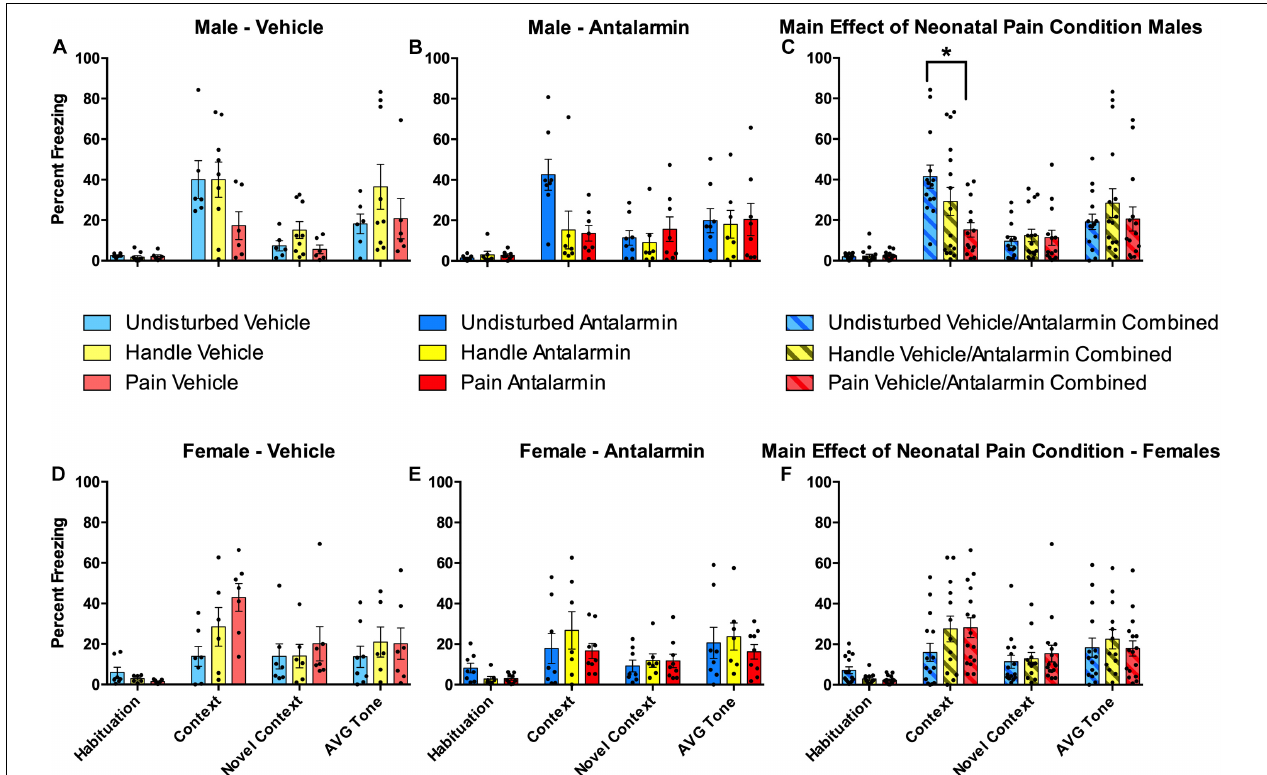
FIGURE 5 | Effects of Antalarmin on freezing for neonatally manipulated rats during the four freezing variables (Habituation, Context, Novel Context, Average Tone) following fear conditioning in Experiment 1. The top three panels represent male Undisturbed, Handled, and Pain (A) vehicle (Undisturbed—N = 8; Handled—N = 12; Pain—N = 9) or (B) Antalarmin (Undisturbed—N = 11; Handled—N = 10; Pain—N = 10) treated rats. (C) The same data were also collapsed across drug to show the main effect of neonatal pain condition on freezing. The bottom three panels represent female Undisturbed, Handled, and Pain rats treated with (D) vehicle (Undisturbed—N = 7; Handled—N = 9; Pain—N = 8) or (E) Antalarmin (Undisturbed—N = 8; Handled—N = 9; Pain—N = 8), and (F) a panel with the same data collapsed across drug to show the main effect of neonatal pain condition on freezing. These results show that fear conditioning altered subsequent freezing for all groups. For females, vehicle-treated Pain rats had a statistically significantly higher freezing percentage during the Context test compared to Undisturbed vehicle-treated female rats (but not Handled) and no effect of Antalarmin treatment was found in females (all p ’s > 0.10). In males, there was a statistically significant effect of neonatal pain condition only on the Context test which was reversed by Antalarmin. When data were collapsed across drug treatment, neonatal pain significantly lowered Context freezing compared to Undisturbed but not Handled males (all p ’s > 0.1). Data are presented as means with error bars as ± SEM; *denotes significant ( p < 0.05) difference between indicated